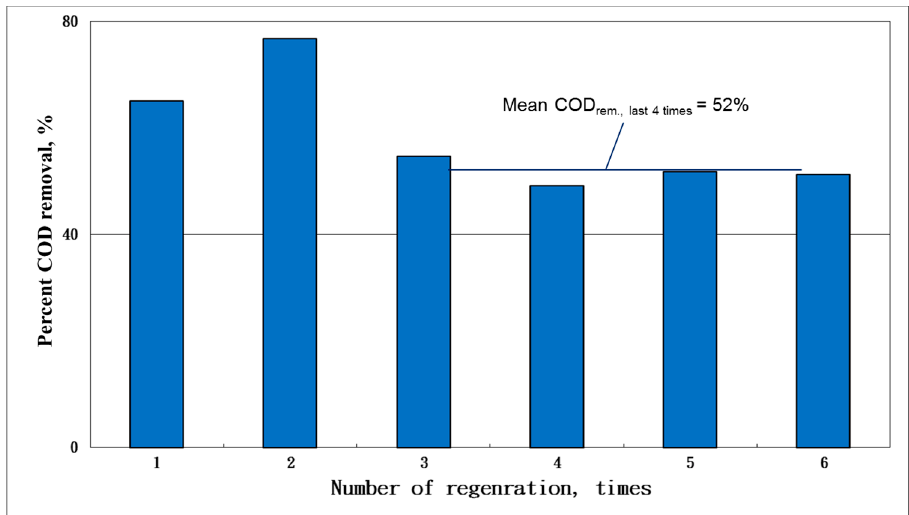
Figure 8. Plots of the percent COD removed versus the number of times AC was regenerated. The results showed that, at the targeted 50% adsorption of the COD, the reuses of the generated ACs seemed doable.